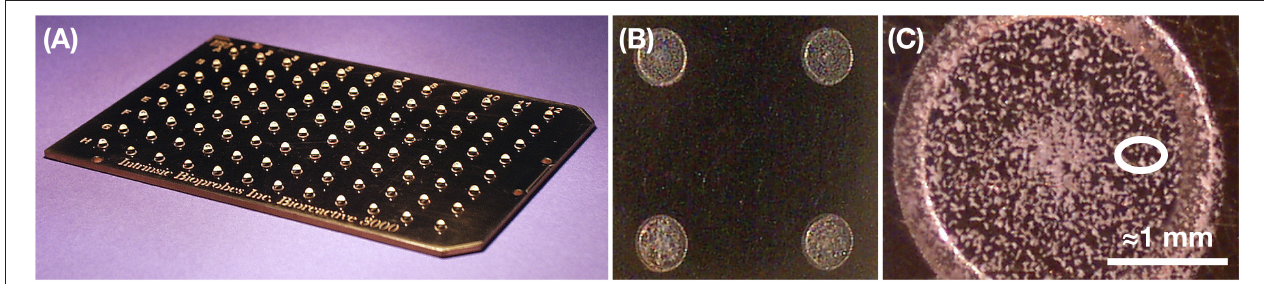
FIGURE 5 | Example possible patterned secondary collector surface that could be robotically inserted into analytical instruments on Earth (here, a MALDI mass spectrometer; see Table 3 ). (A,B) This metal surface comprises 8 × 12 hydrophilic spots, each 2–3mm in diameter. Sample accumulated on the plate can be concentrated for analysis by depositing droplets (here, of laser ablation matrix, i.e., a solution of small molecules absorbing at the laser wavelength) and letting dry prior to insertion into the mass spectrometer. These steps can be carried out robotically so as to minimize exposure to Earth’s biosphere and human contamination. (C) Close-up of a spot, with a typical laser spot size depicted by a white oval. Credit: Intrinsic Bioprobes Inc. (now part of Thermo Fisher